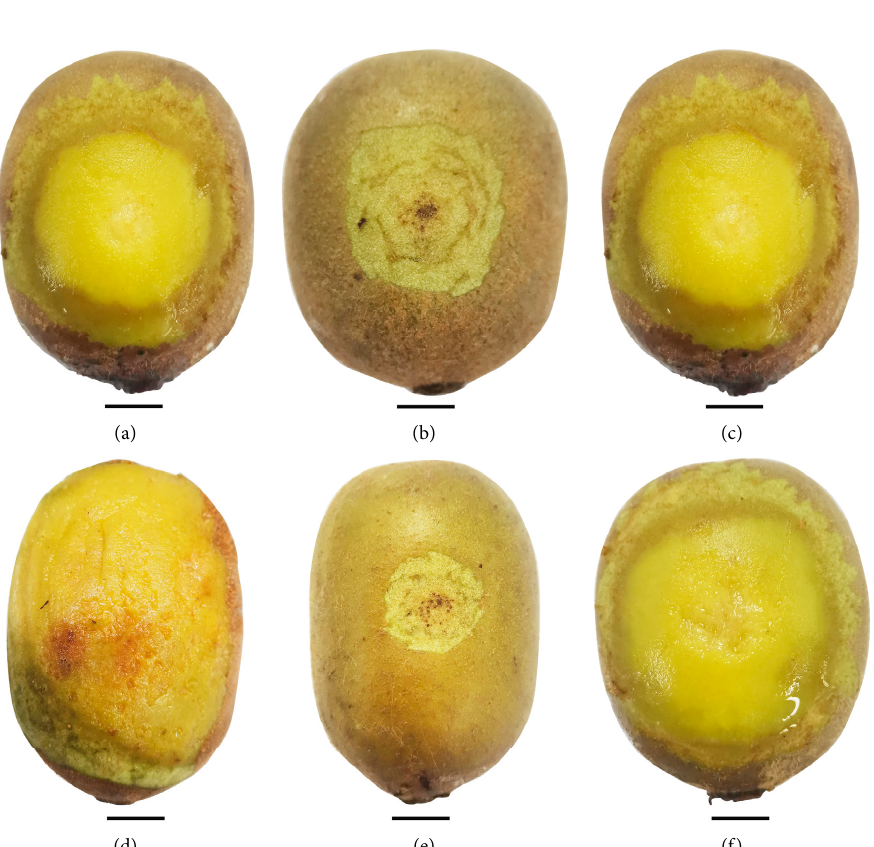
Figure 2: The symptoms of F1 and F4 strains in pathogenicity test. (a) and (d): Natural occurrence characteristics of kiwifruit fruit rot disease, (b) and (e): pathogenicity test CK group, (c) and (f): pathogenicity test characteristics; (a)–(c) F1 strain. (d)–(f) F4 strain. Scale bar: